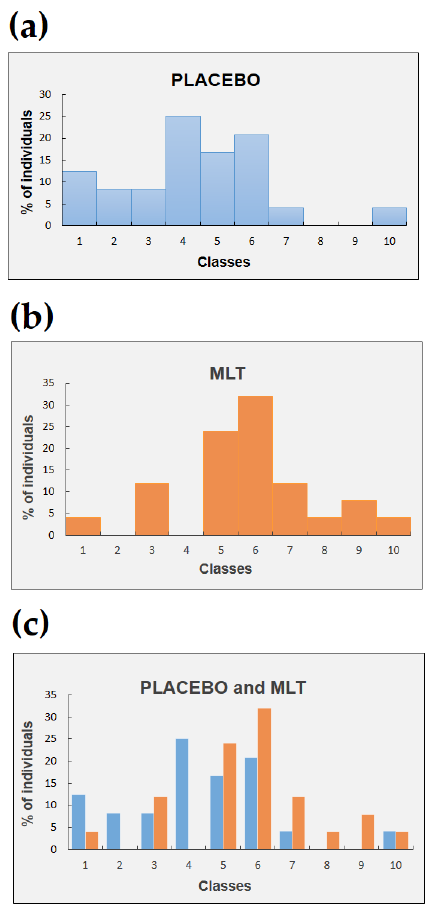
Figure 1. Percentage of individuals schematized by hystograms vs. classes. ( a ) Individuals (blue hystograms) who have received placebo. ( b ) As in ( a ) but for individuals (orange hystograms) who